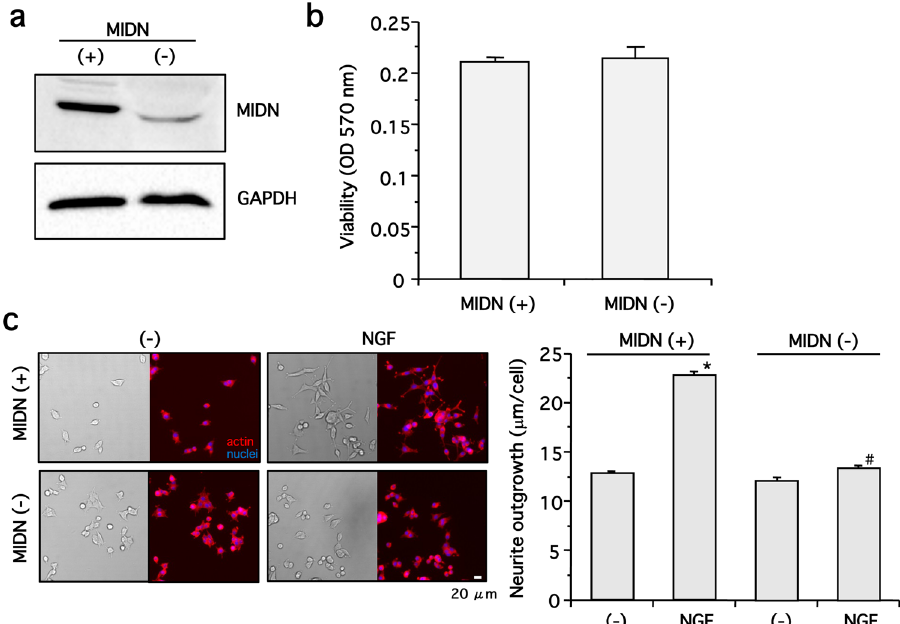
Figure 4. MIDN is necessary for NGF-induced neurite outgrowth in PC12 cells. ( a ) MIDN-positive ( + ) and -negative ( − ) PC12 cells were generated using CRISPR/Cas9 technology, then MIDN protein expression was examined by Western blotting. (b) The viability of the MIDN-positive ( + ) and -negative ( − ) PC12 cells was examined using an MTT assay, measuring absorbance at 570 nm (n = 5). (c) The MIDN-positive and -negative PC12 cells were incubated in the presence or absence of 100 ng/ml NGF in serum-free medium for one day. Cells were fixed in 4% paraformaldehyde, and the actin filaments and nuclei were stained with rhodamine- phalloidin (5 U/ml) or Hoechst-33258 (1 μ g/ml), respectively. Forty randomly selected areas per well were photographed, then the total neurite length was divided by the number of nuclei to give the neurite length per cell ( μ m/cell). While NGF significantly promoted neurite outgrowth in MIDN-positive cells compared with drug-free control ( * p < 0.05, n = 6), the neurite outgrowth in MIDN-negative cells was attenuated compared with MIDN-positive cells ( # p < 0.05, n =